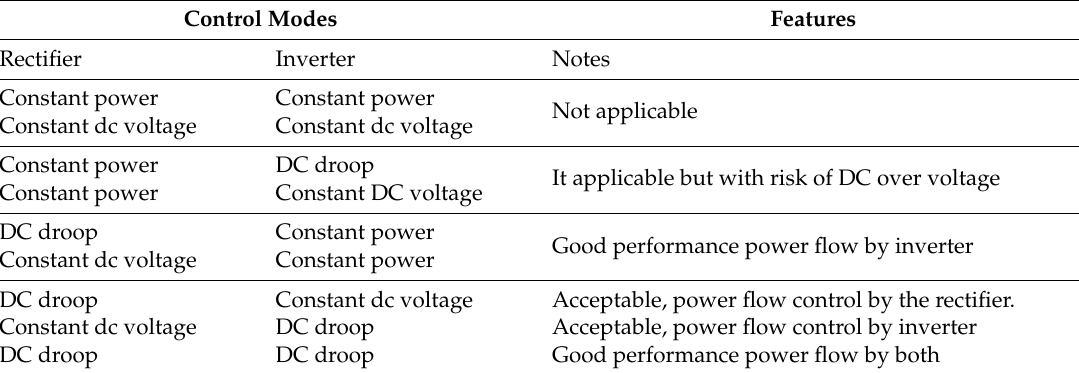
Summaries various control configuration for voltage source converter-high voltage direct